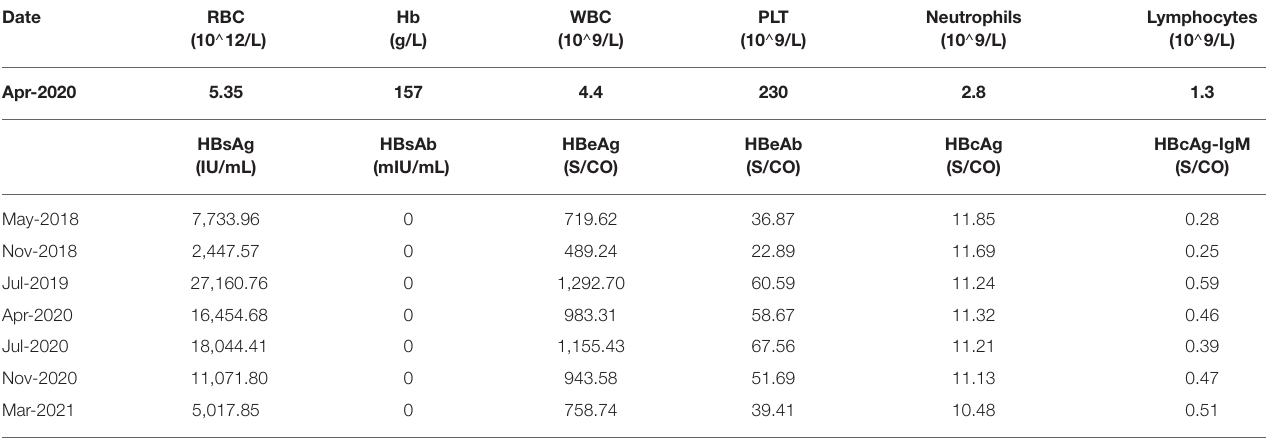
TABLE 2 | Routine blood parameters and the kinetics of HBV-specific antigens and antibodies of patient